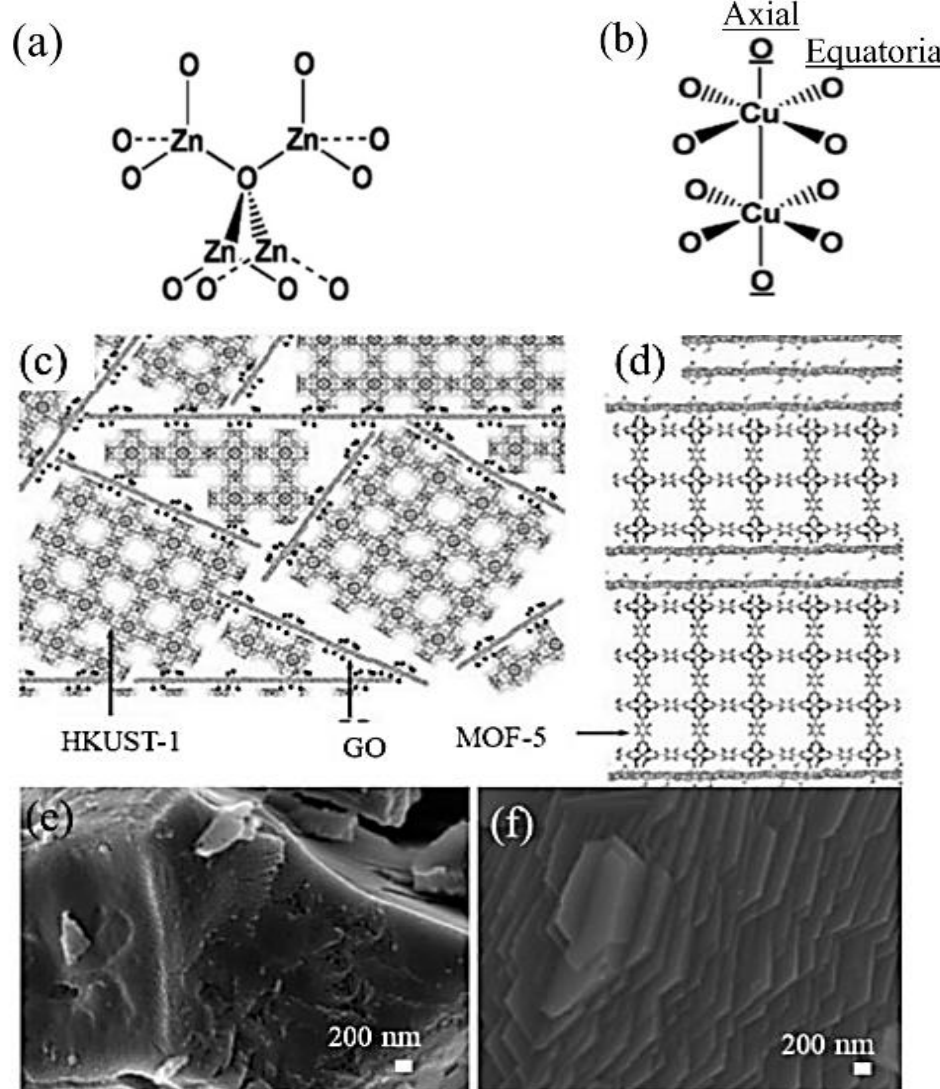
Figure 3. Oxygen coordination on sites available in ( a ) MOF − 5 and ( b ) HKUST − 1. Envisioned structures for the hybrid materials based on ( c ) HKUST − 1 and ( d ) MOF − 5; Scanning Electron Microscopy (SEM) images of ( e ) HKUST − 1/GO and ( f ) MOF − 5/GO. Reproduced with permission from [8]. Copyright 2011, Springer.